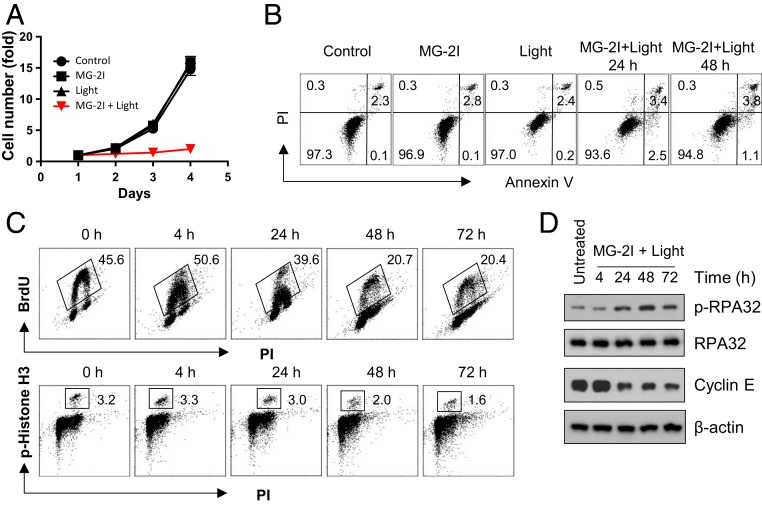
Mitochondrial dysfunction leads to nuclear DNA replication stress. (A) HEK293 Mito-FAP cells were treated with MG-2I (50 nM), light (5 min), or light (5 min) in the presence of MG-2I (50 nM). Cell proliferation was determined by a CyQuant assay at indicated time points. Data are represented as mean ± SD of 4 wells. A representative experiment is shown. (B) Apoptotic cell death in HEK293 Mito-FAP cells after treatment with MG-2I (50 nM), light (5 min), or light (5 min) in the presence of MG-2I (50 nM) was determined by Annexin V and PI staining at indicated time points. Numbers indicate the percentages of each population positive or negative with Annexin V or PI staining. (C) The effect of the exposure to light (5 min) in the presence of MG-2I (50 nM) on cell cycle progression was determined by BrdU incorporation (DNA replication) and phosphorylation of histone H3 (mitosis). Numbers indicate the percentages of cell population positive for incorporating BrdU or phosphorylated histone H3. (D) The phosphorylation of RPA32 and the protein level of Cyclin E after HEK293 Mito-FAP cells treated with light (5 min) in the presence of MG-2I (50 nM) were determined by western blot.